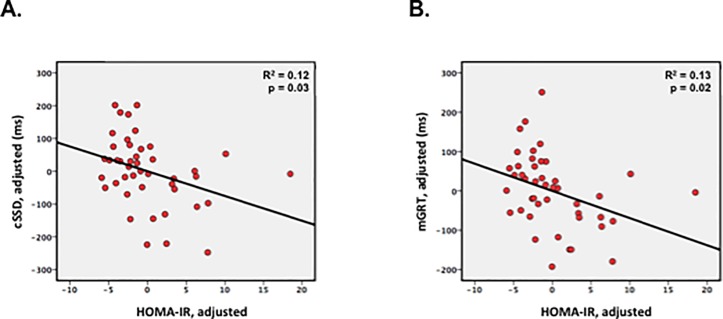
HOMA-IR is the dominant predictor of overall Stop Signal Task performance in obese T2DM participants.A) Increasing insulin resistance (HOMA-IR) predicts poorer overall performance (shorter critical stop signal delay, cSSD). B) This degradation in SST performance is a consequence of faster go speeds (shorter mGRT) with increasing insulin resistance. Models include age and metformin dose as covariates.